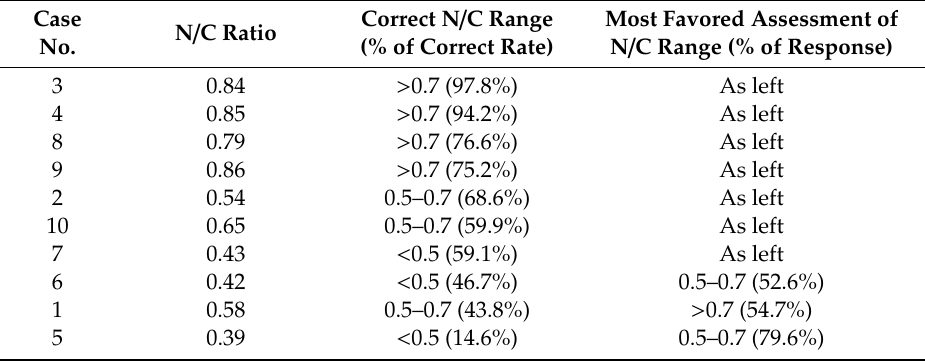
Table 3. The correct rate of nuclear-to-cytoplasmic (N / C) ratio